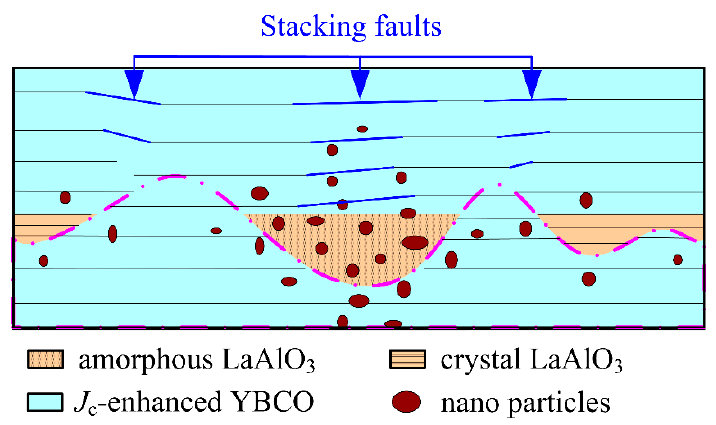
Figure 8. Schematic illustration for enhanced J c in YBCO/LAO/YBCO quasi-trilayer architecture. In the quasi-trilayer, the LAO layer is discontinuous.